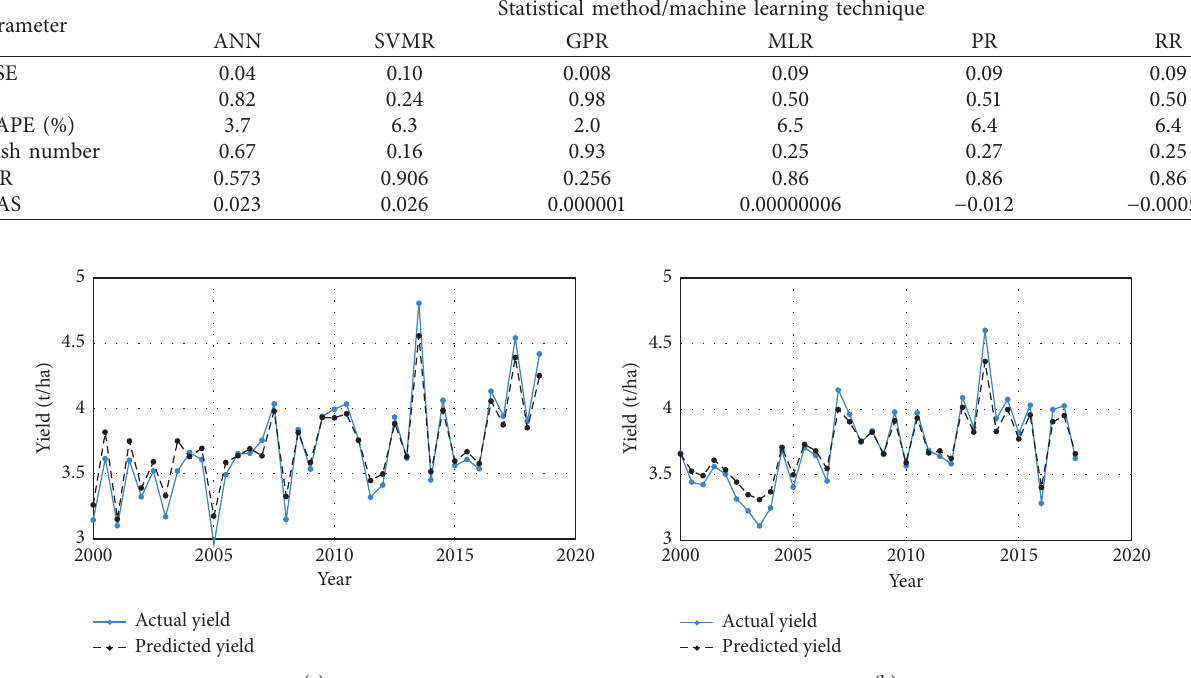
Figure 4: Comparison of actual vs. GPR-based predicted rice yield (2000–2018). (a) Kurunegala district. (b) Puttalam